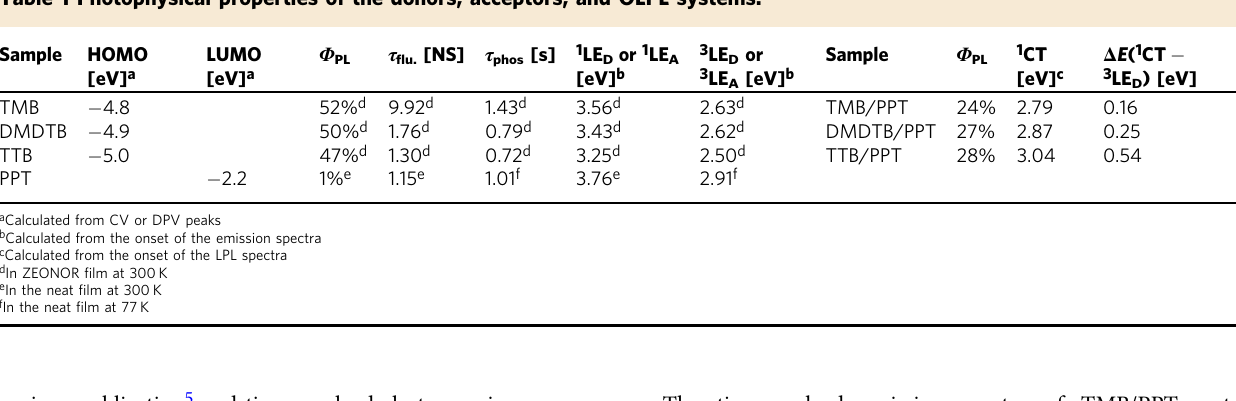
Table 1 Photophysical properties of the donors, acceptors, and OLPL systems.